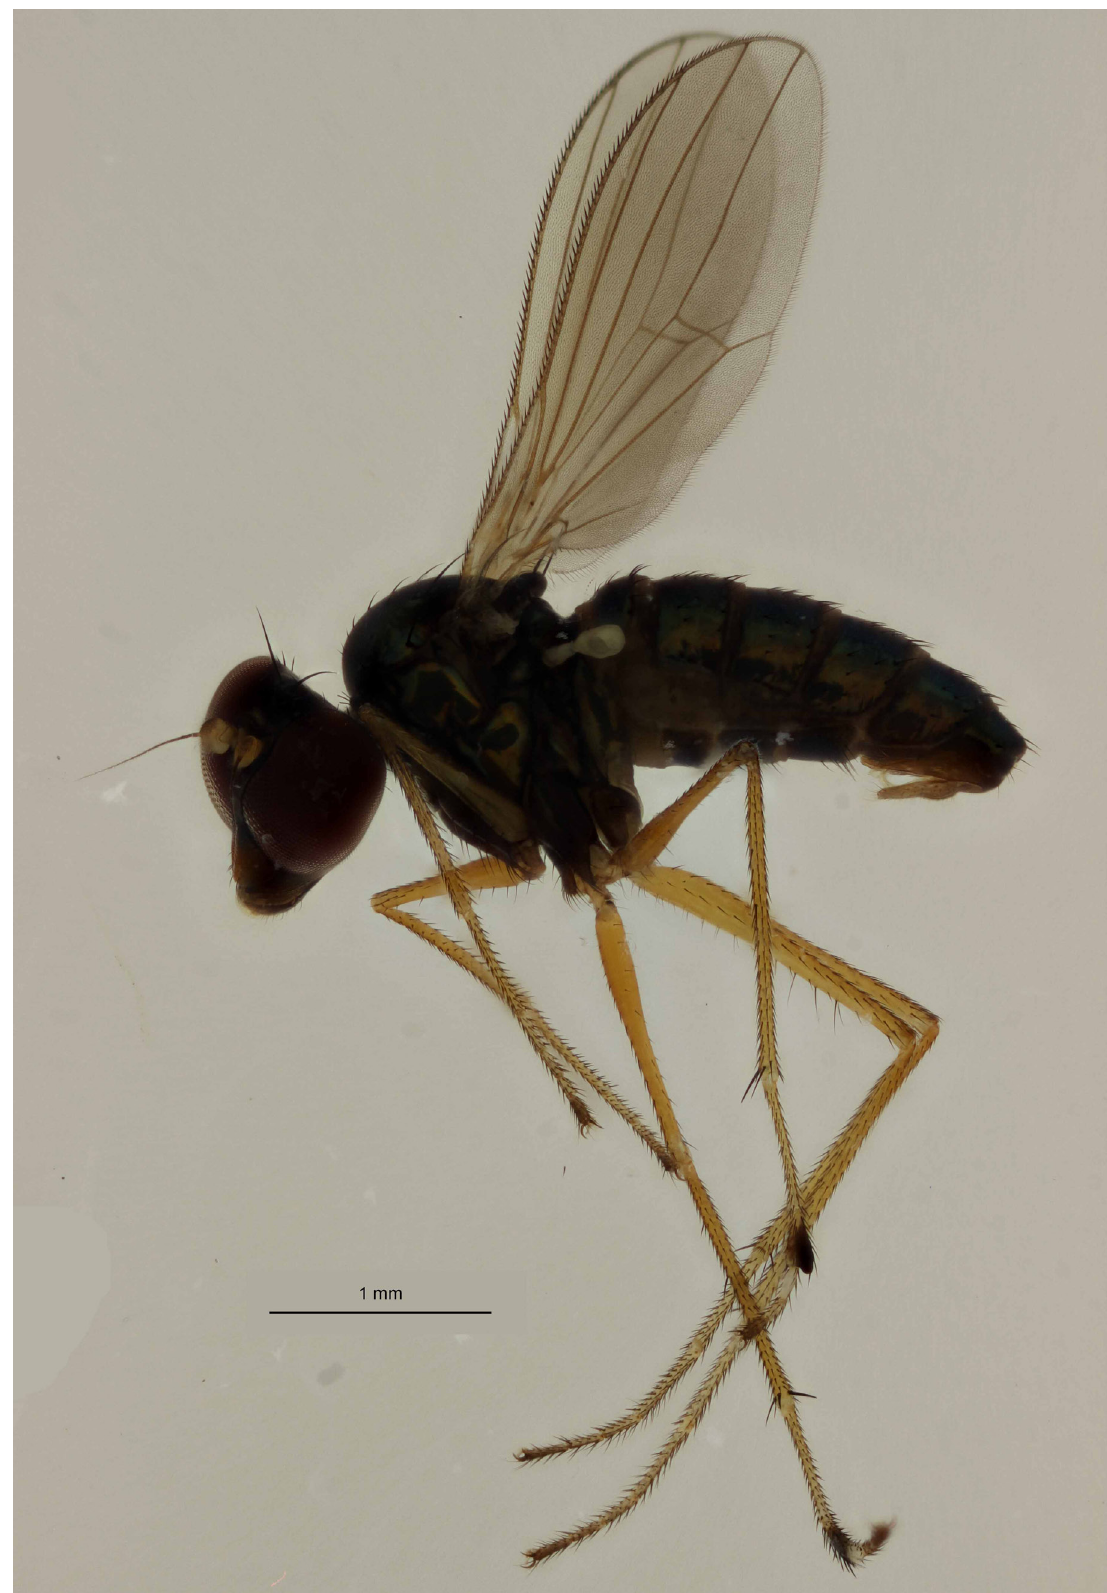
Fig. 17. Thinophilus parmatus Grootaert & Meuffels, 2001, ♂,